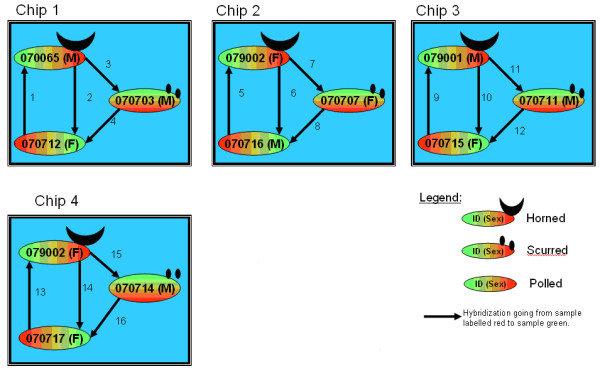
Experimental design